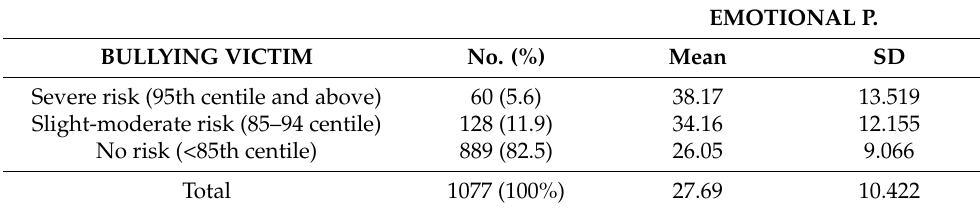
Table 11. Risk of emotional problems and the mean scores on the bullying scale.